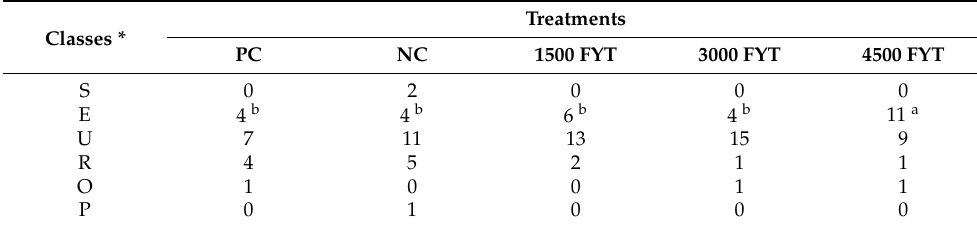
Table 4. Effect of treatments on the number of carcasses categorized by lean meat yield according to the European Carcass